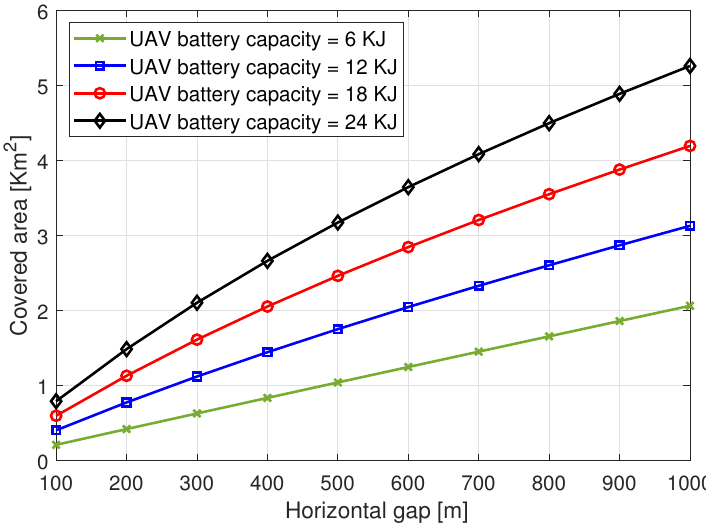
Figure 12. The area covered by the UAS as a function of the horizontal gap for various UAS battery